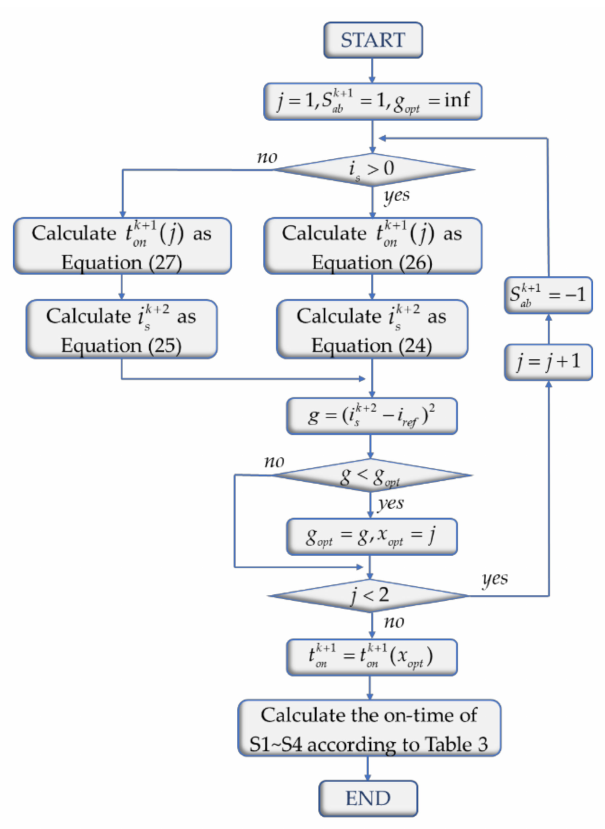
Figure 9. The flow chart of the inner current controller with dead-time